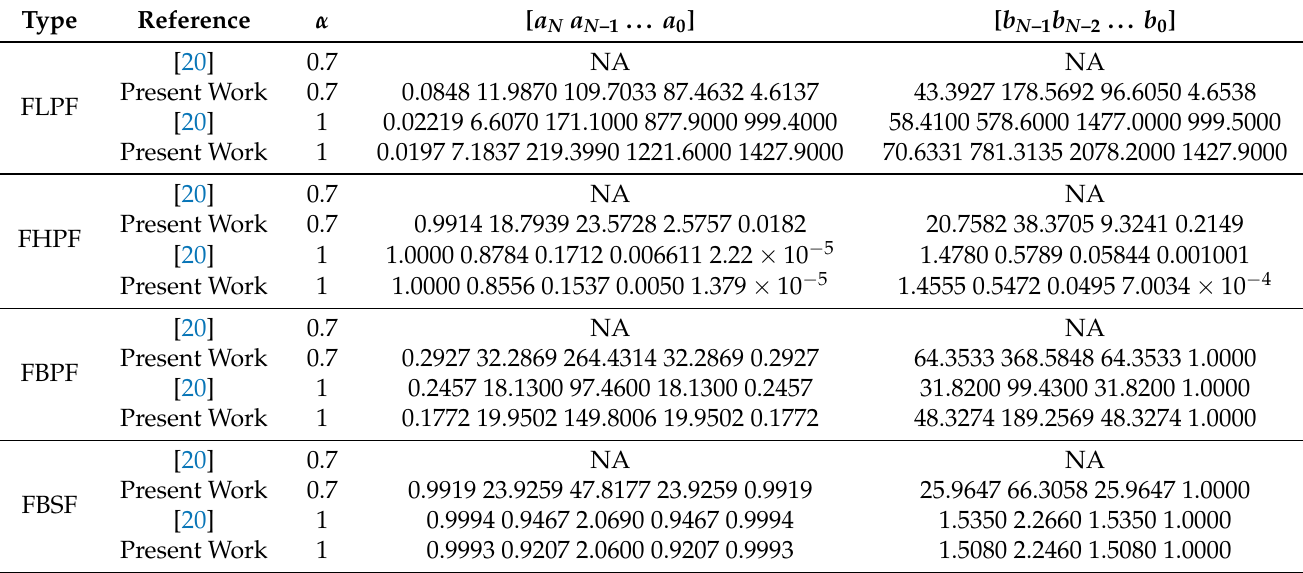
Table 10. Coefficients of the proposed and reported filters for β = 0.3 (NA: Not Applicable).